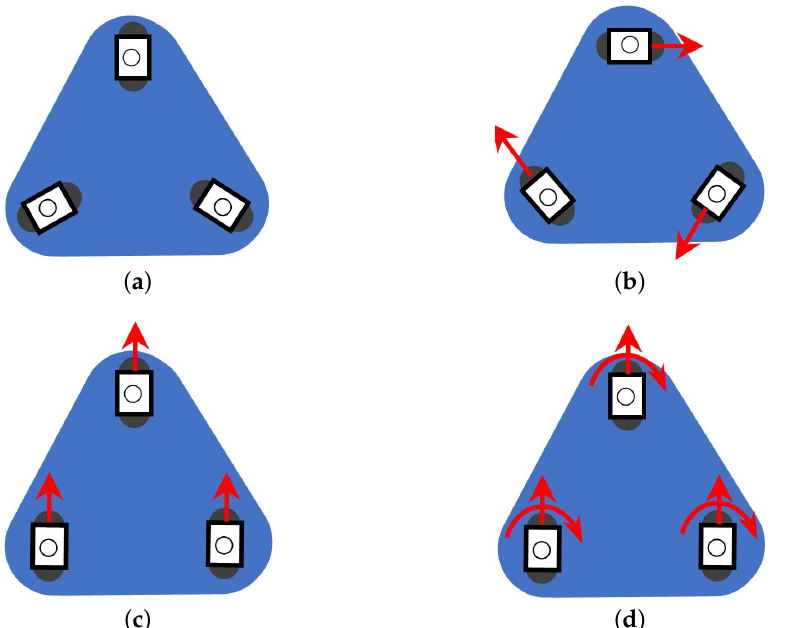
Figure 4. Motion models of the omnidirectional chassis. ( a ) Parking. ( b ) Turning in situ. ( c ) Driving in a straight line (no steering). ( d ) Meandering path driving.